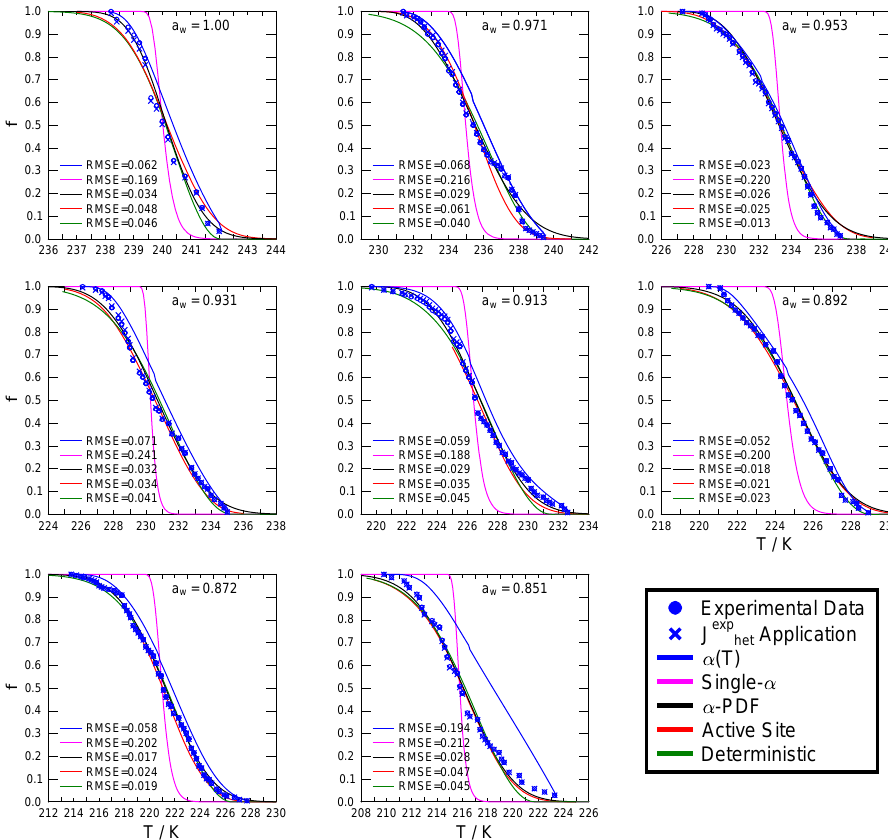
Fig. 4. Summary of different immersion freezing descriptions for water and aqueous ( NH 4 ) 2 SO 4 droplets containing leonardite as a function of T and a w . The experimentally derived cumulative frozen fraction, f , of droplets in 0.2K temperature increments is represented by blue circles. Blue crosses indicate application of experimentally derived heterogeneous ice nucleation rate coefficient, J exp magenta, black, red, and green lines represent α(T ) , single- α , α -PDF, active sites, and deterministic model, respectively. The fit quality is given by the root-mean-square error,